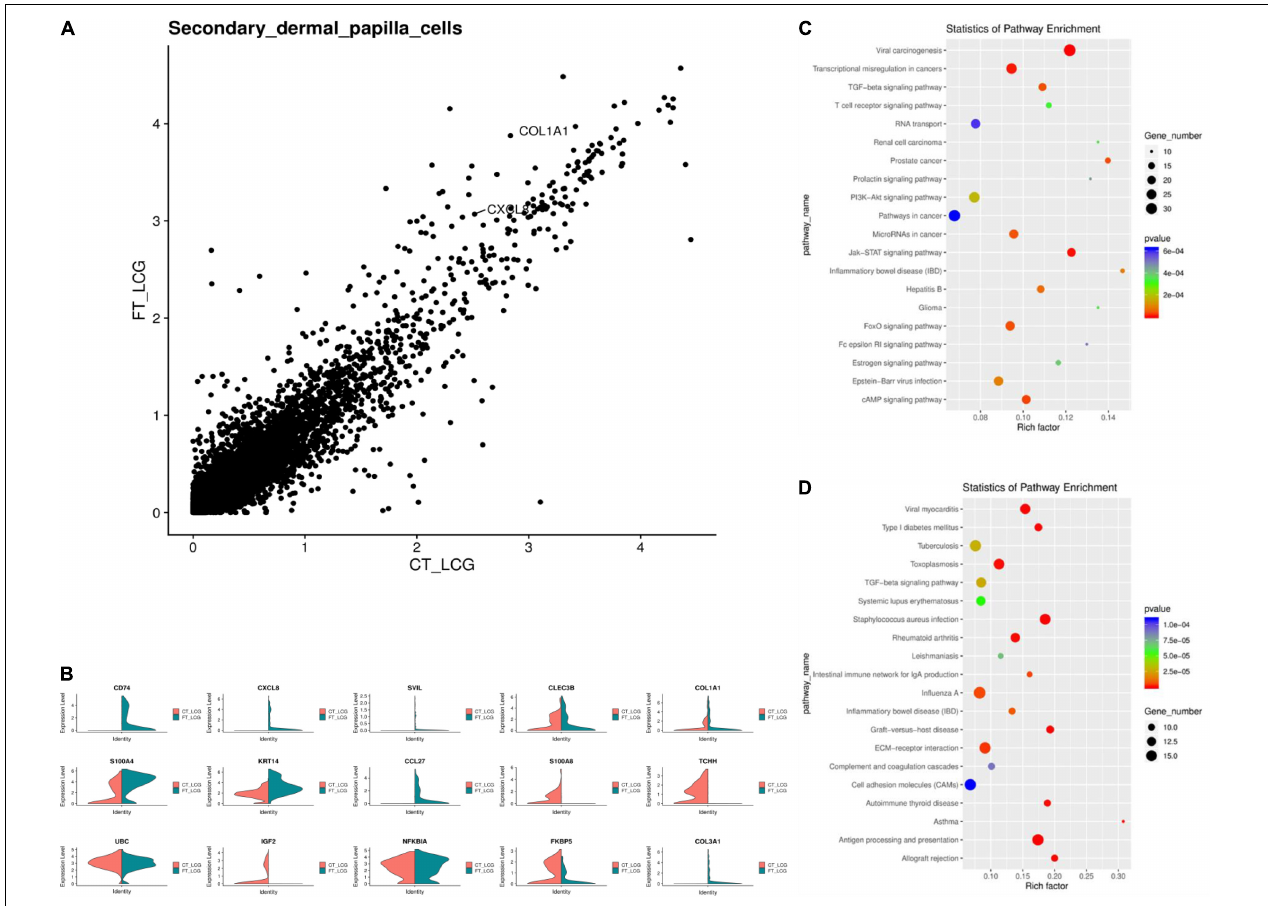
FIGURE 10 | Analysis of DEGs between CT-LCG and FT-LCG SDPCs. (A) Scatterplot of DEGs in SDPCs. (B) Top 20 up-expressed genes in SDPCs. Red: CT-LCG; Green: FT-LCG. (C) KEGG analysis in CT-LCG. (D) KEGG analysis in